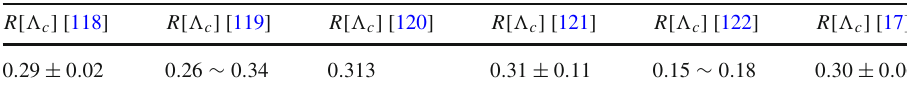
Table 5 Semileptonic (cid:2) → (cid:2) ( 1 / 2 + ) LFU b c